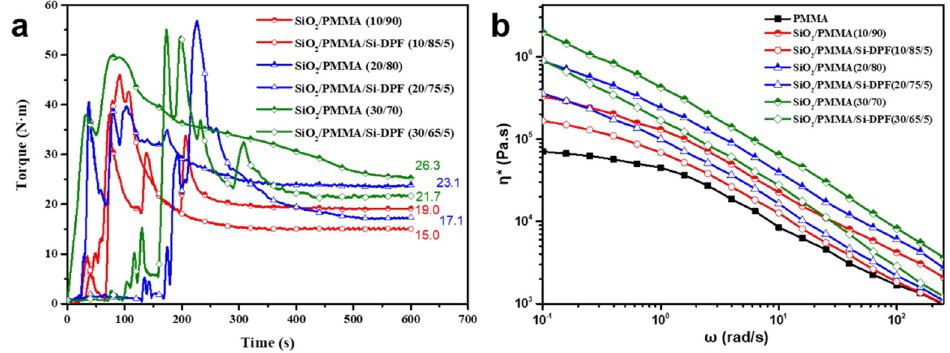
Figure 5. ( a ) Torque rheological analysis of SiO 2 /PMMA composites. ( b ) Complex viscosity versus frequency of samples. Temperature: 180 ◦ frequency of samples. Temperature: 180 ℃ .